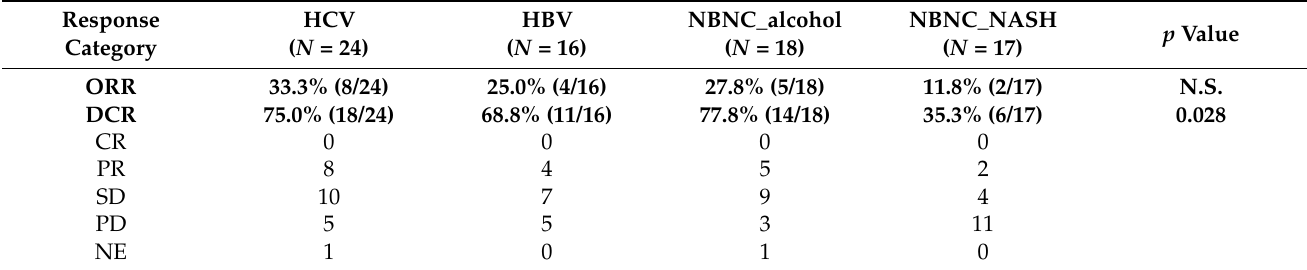
Table 2. Atezolizumab + Bevacizumab: ORR by Etiology (RECIST v1.1). N = 77.